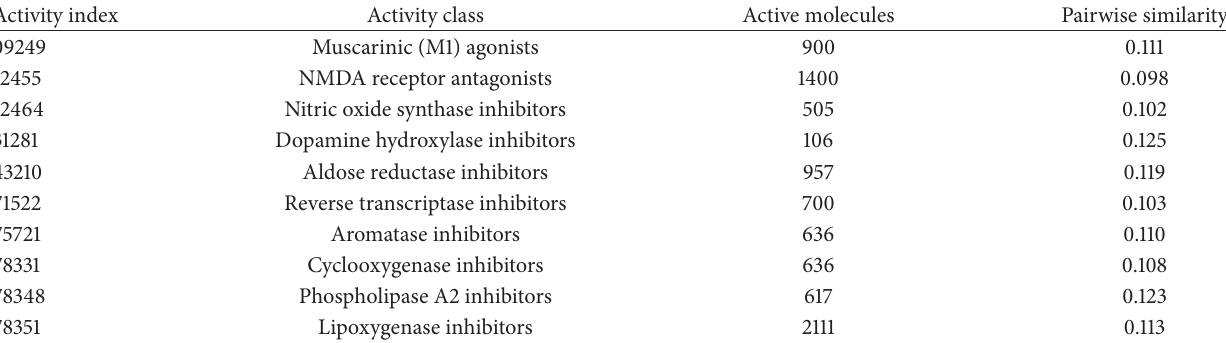
Table 3: MDDR activity classes for DS3 data set.